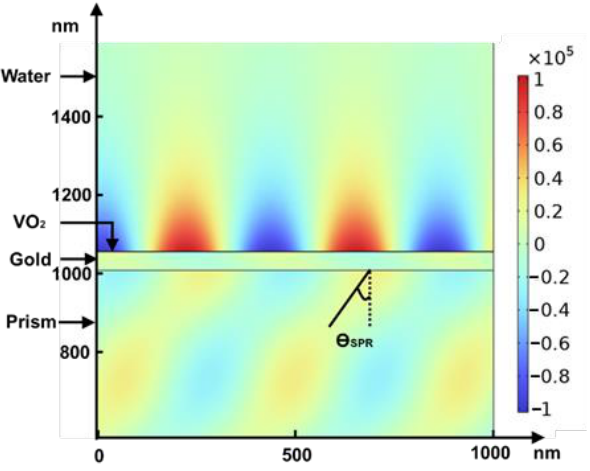
Figure 5. Electric field (y component in V/m) distribution inside the structure, given that the thicknesses of the gold film and VO 2 are 47 and 1 nm, respectively, excitation is 630 nm, and temperature is 20 °C.